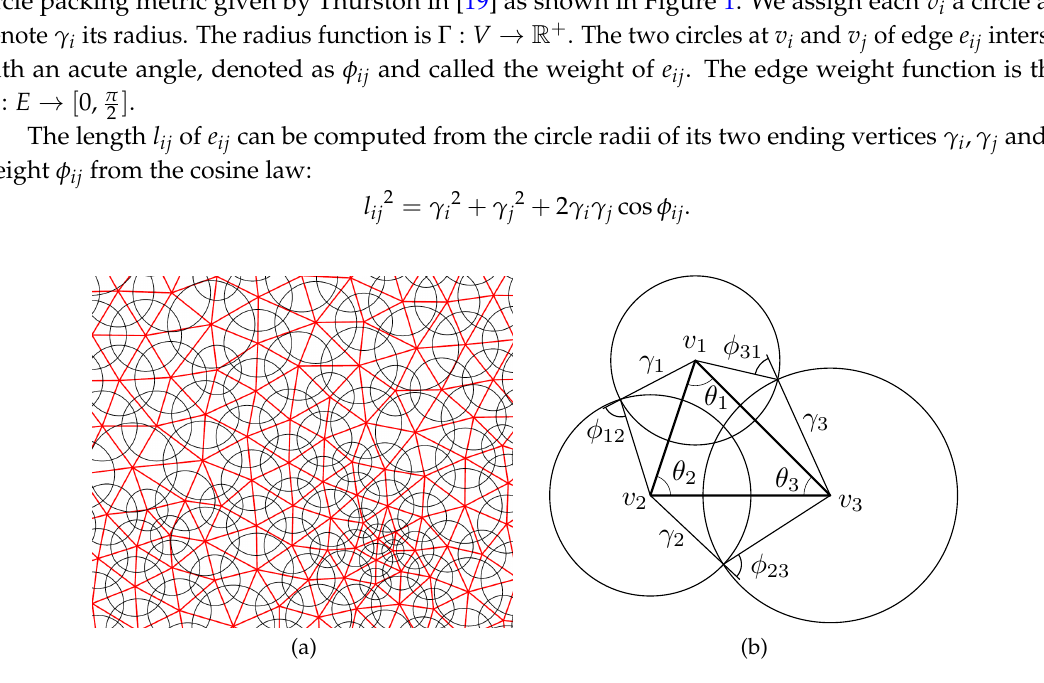
Figure 1. Circle packing metric. ( a ) Flat circle packing metric on a triangular mesh; ( b ) circle packing metric on a